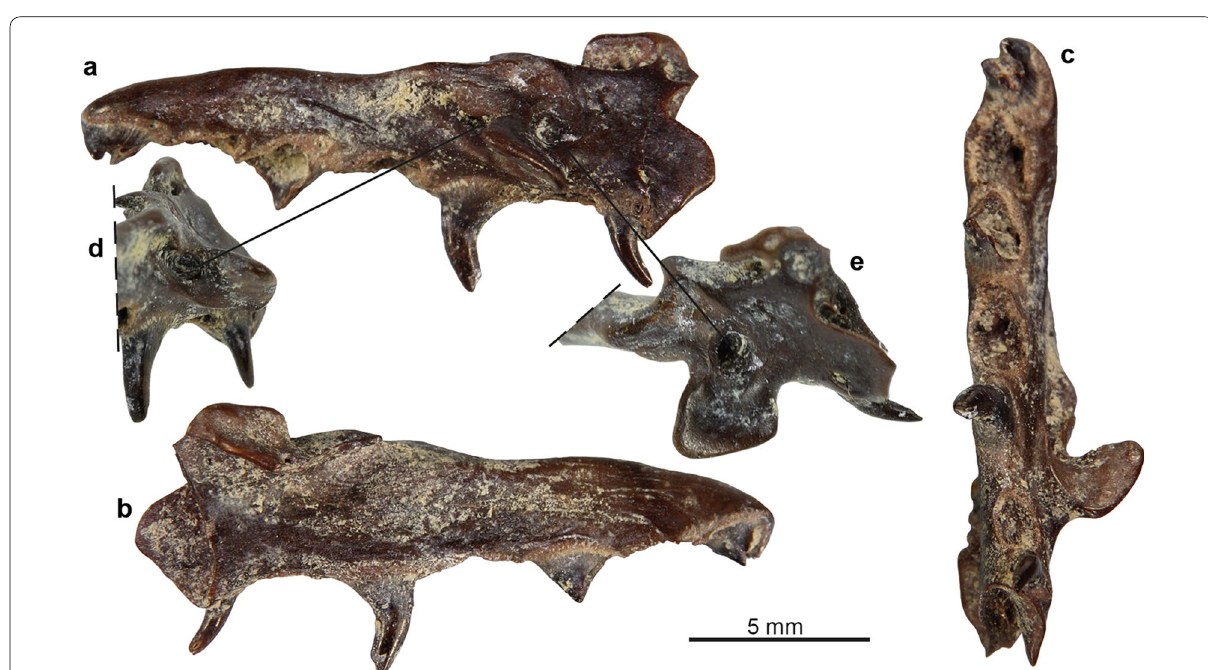
Fig. 38 Paleryx rhombifer from Hordle Cliff: left palatine (NHMUK PV R 10907) in labial ( a ), medial ( b ), ventral ( c ), anterior ( d ), and posterior ( e ) views. Black lines indicate the entrance and exit of the palatine